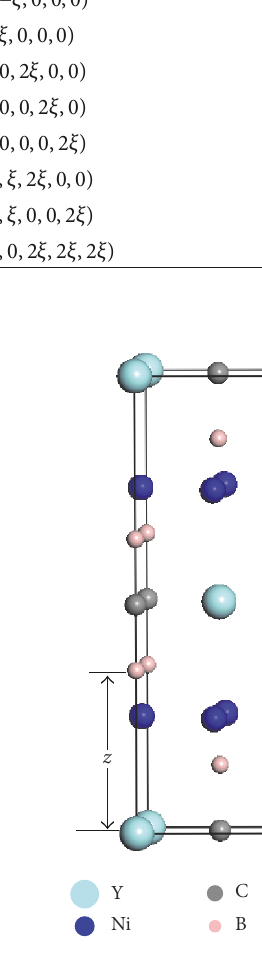
Figure 1: Crystal structure of YNi 2 B 2